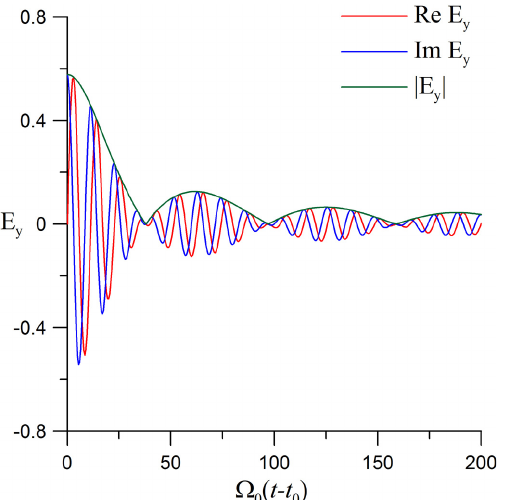
Fig. 5. Temporal evolution of E x far from the source, (x 0 − x)/l = 0 . 1.